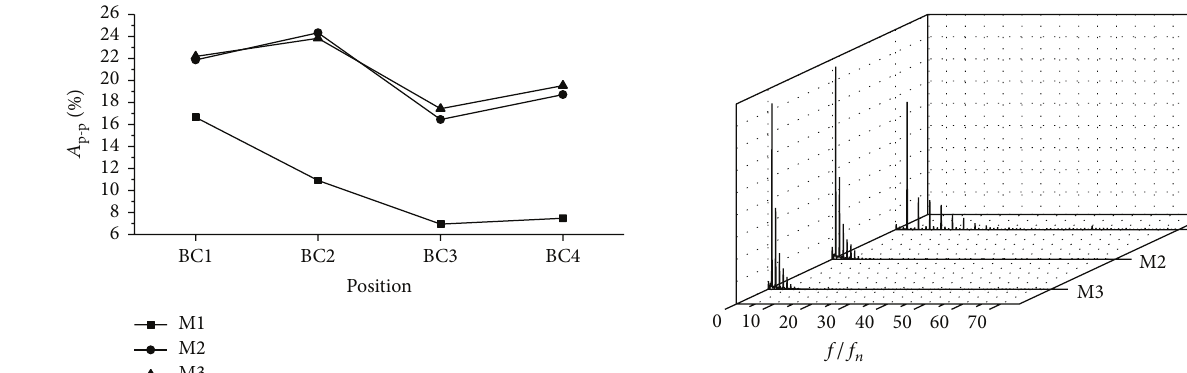
Figure 13: Frequency spectrum of the pressure fluctuations at Point